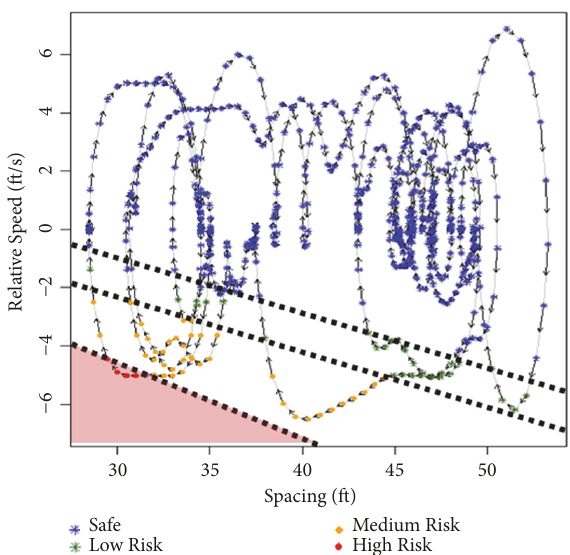
Figure 3: Collision risk estimated with the temporal spacing and relative speed